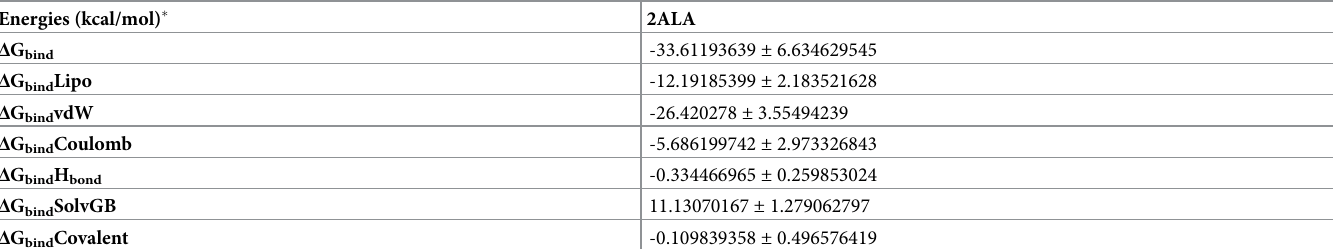
Table 2. Binding energy calculation of Lupenone with 2ALA and non-bonded interaction energies from MMGBSA trajectories. Energies (kcal/mol)